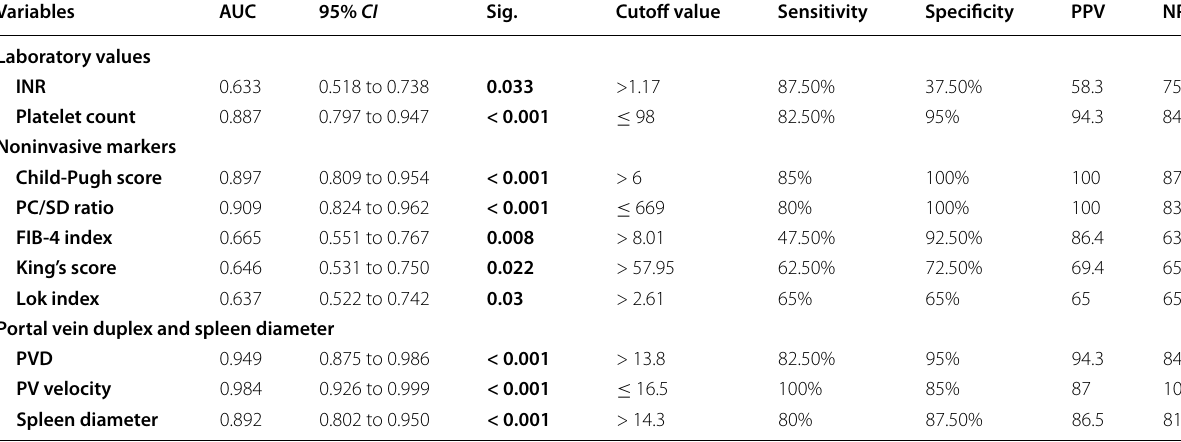
Table 6 ROC curve for predicting the presence of CSPH in HCV‑related liver cirrhosis